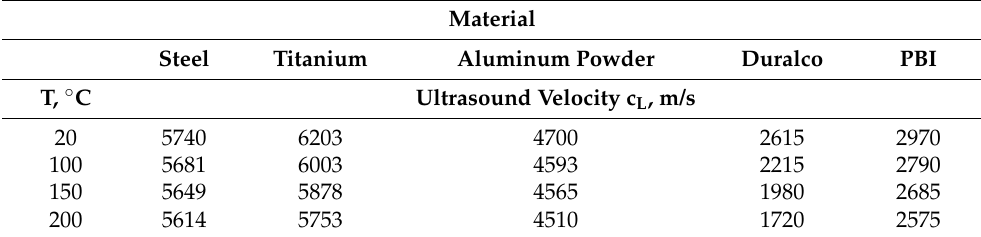
Table 2. Ultrasound velocities in materials of buffer